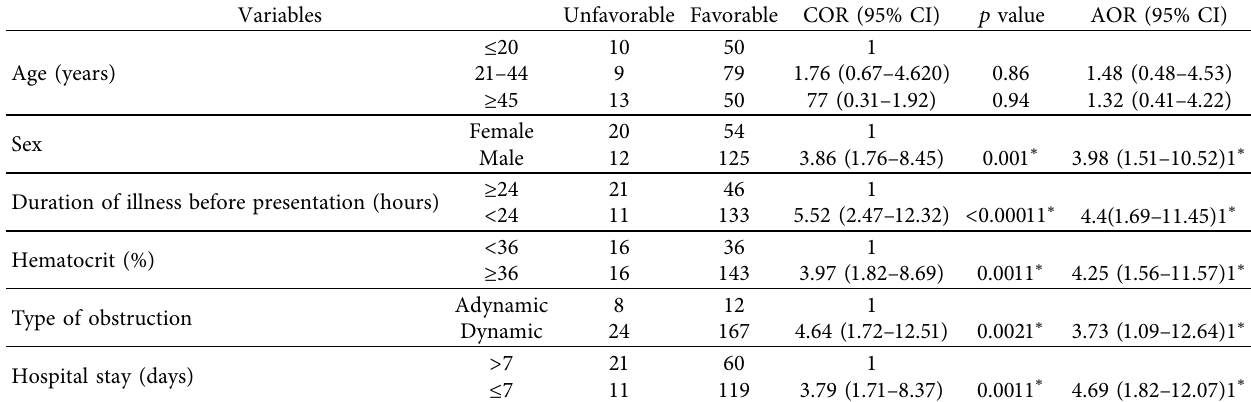
Table 3: Predictors of the management outcomes of small intestinal obstructions in Nekemte Referral Hospital from January 1, 2014, to December 30,